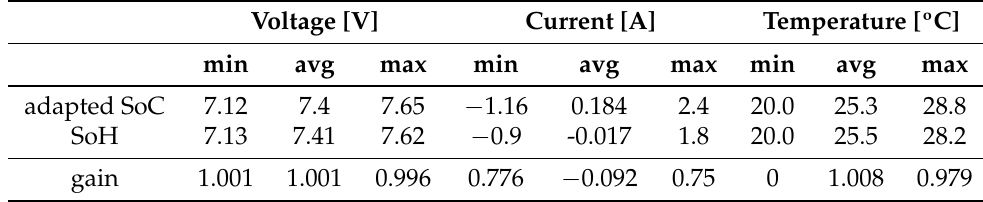
Table 17. Battery 3 during a month of simulation: Case 3.